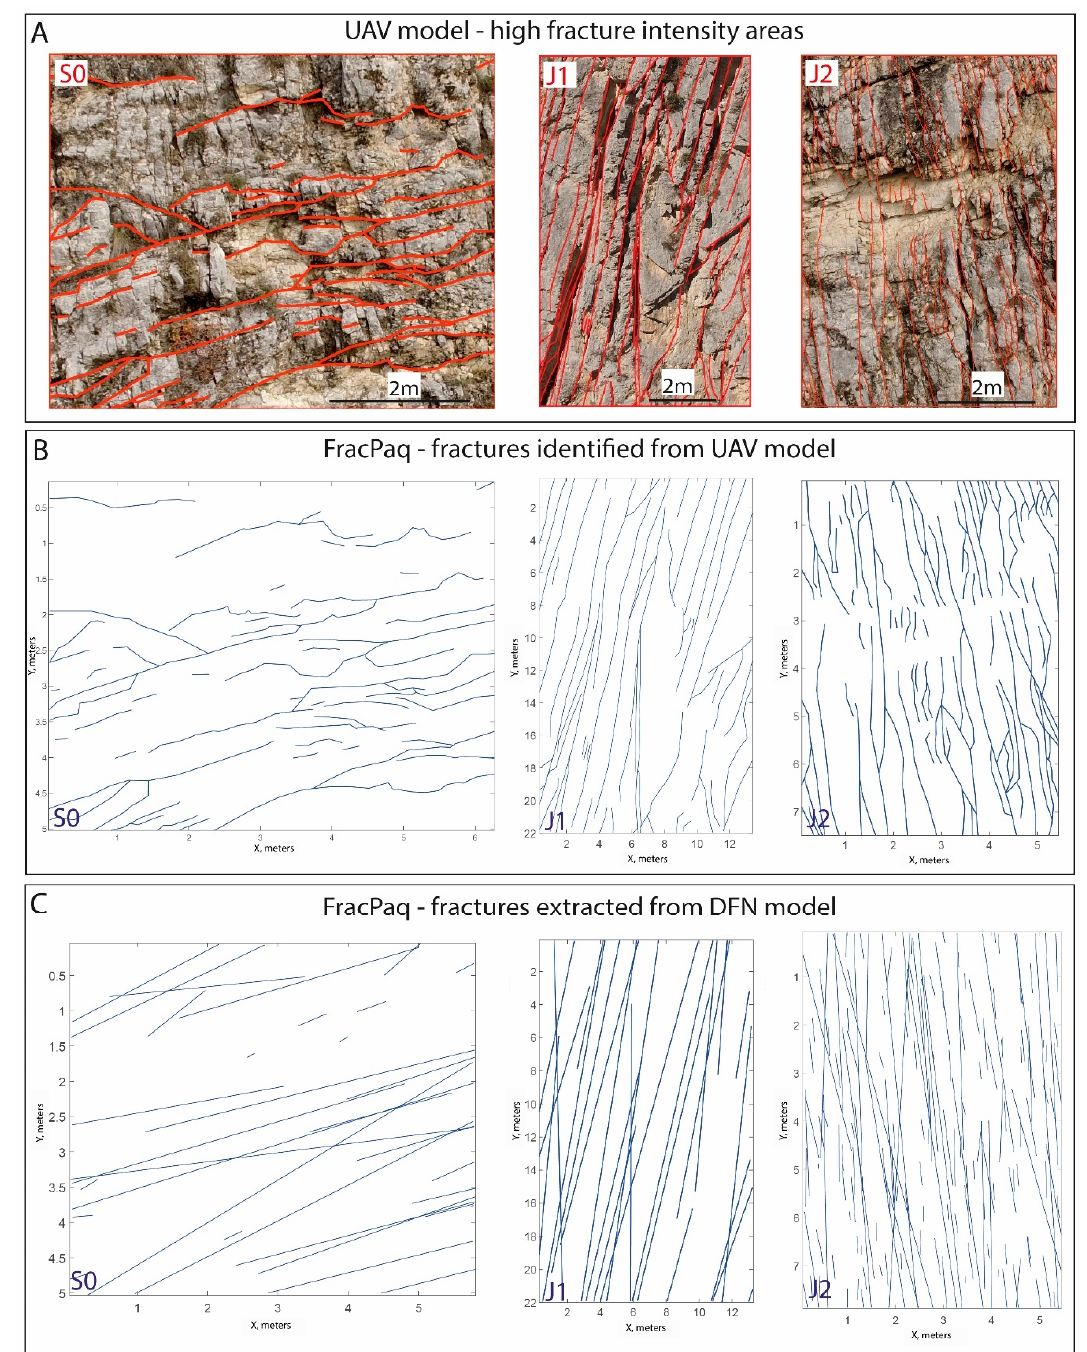
Figure 8. ( A ) Example of sampling windows from high fracture intensity areas. ( B ) Fractures identified in sampling windows and used for the calculation of P 21 . ( C ) Sections extracted from DFN 1 after model validation.